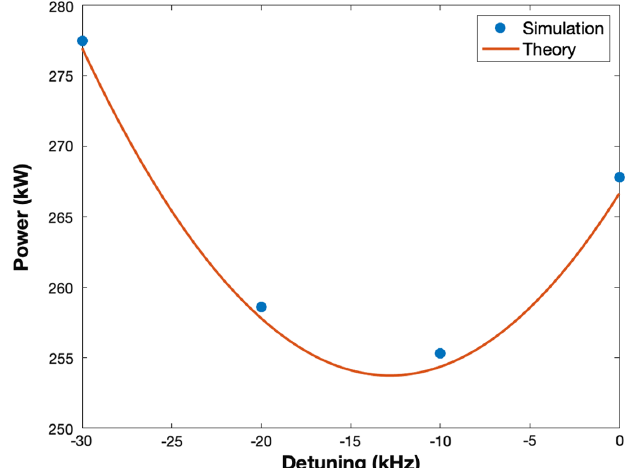
FIG. 24. Average klystron power with Q